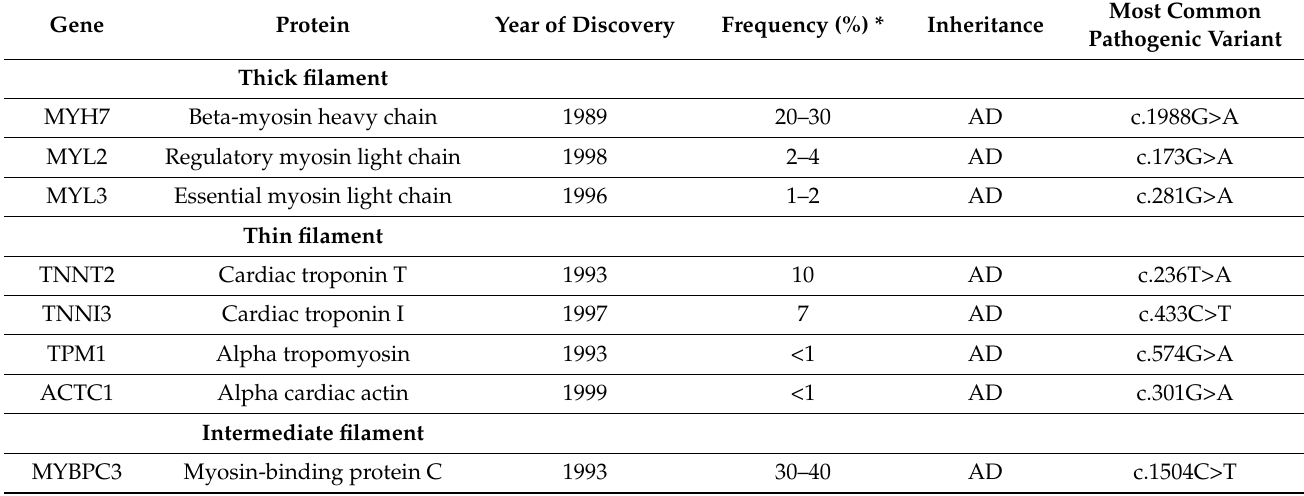
Table 1. Main sarcomeric genes associated with